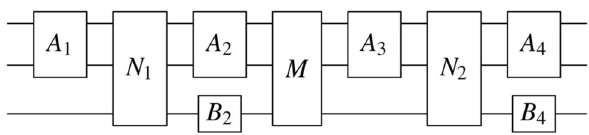
Fig. 1 Circuit representation of the Khaneja – Glaser decomposition of an arbitrary element of SU(8). As seen in the fi gure, A 1, A 2, A 3, A 4 and B 1, B 2 are unitaries acting on smaller spaces of two qubits and one qubit, respectively. The remaining three-qubit gates, N 1, N 2 and M , are generated by commutative algebras and can be easily Trotterised without introducing errors. In the three-qubit case, the optimal circuits implementing these are given in ref. 19